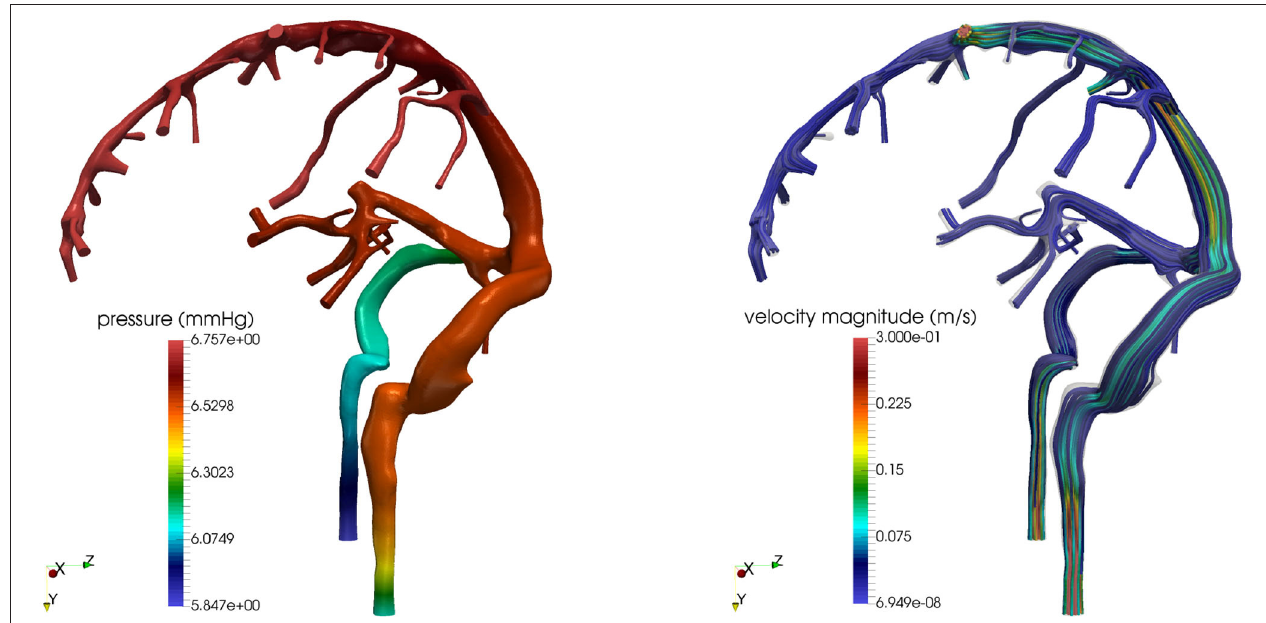
FIGURE 4 | Cerebral venous hemodynamics. (Left) Pressure field. (Right) Streamlines. Images reproduced from Bertoluzza et al. (2017), with